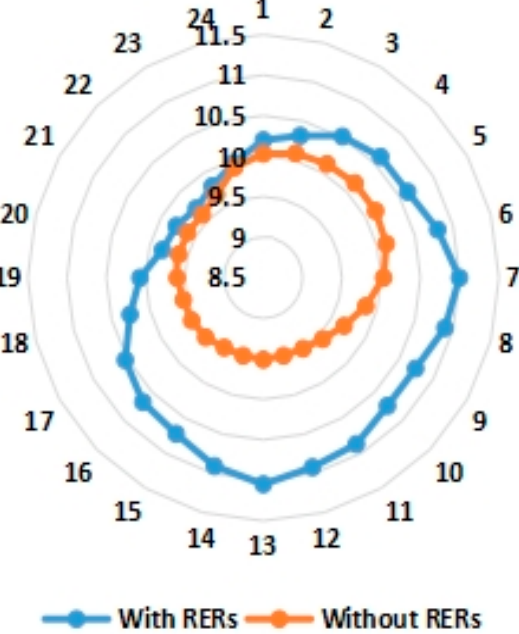
Figure 9. Summation of the voltage stability index with and without RERs.